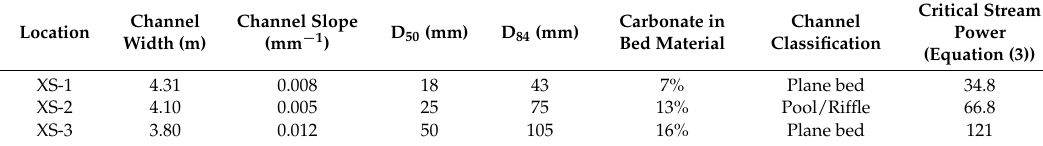
Table 1. Values of parameters measured at each the three locations in Blowing Cave,